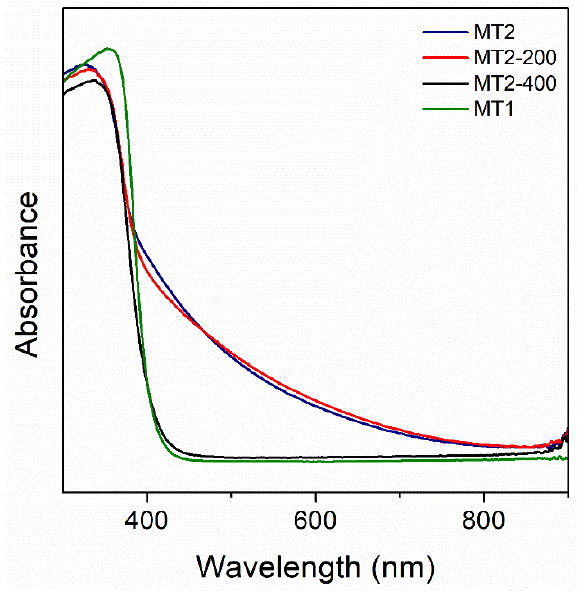
Figure 7. UV–Vis di ff use reflectance (DR) spectra of material (MT1) and all MT2 Figure 7. UV–Vis diffuse reflectance (DR) spectra of material (MT1) and all MT2 samples.